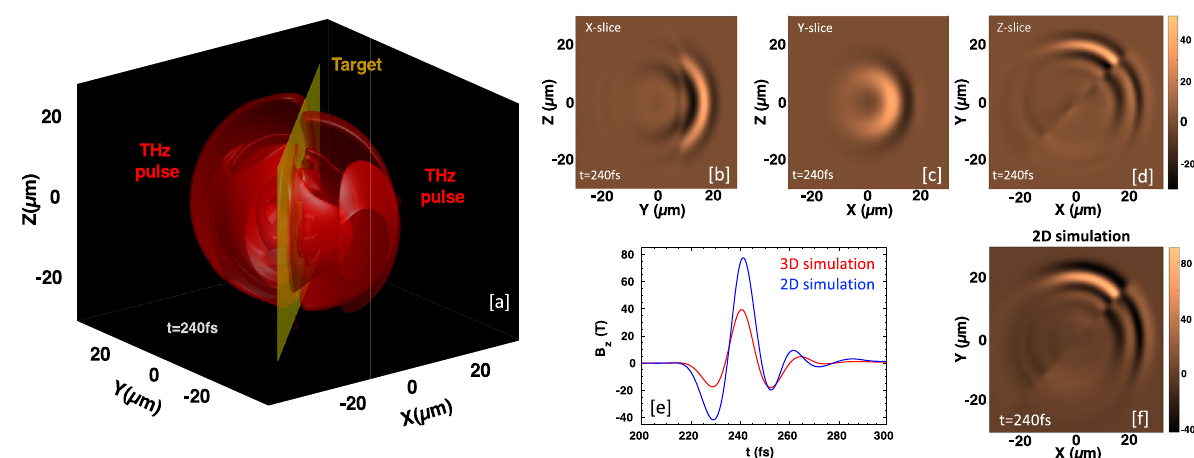
240 fs . ( b – d ) 2-D slices =